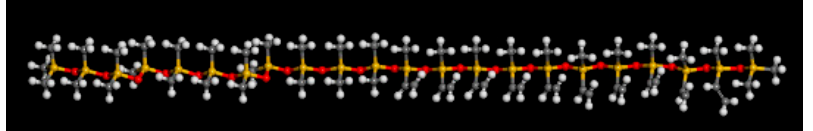
Figure 2. Initial molecular model. O: red, Si: yellow, C: gray, H: white.